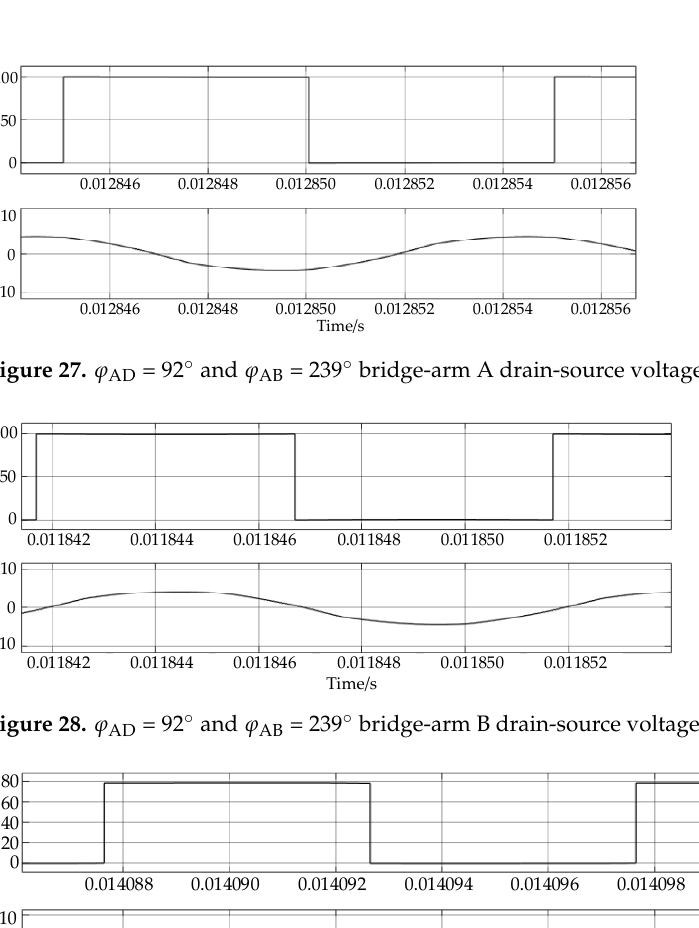
Observe the ZVS of each bridge arm as shown in Figures 27–29 below.